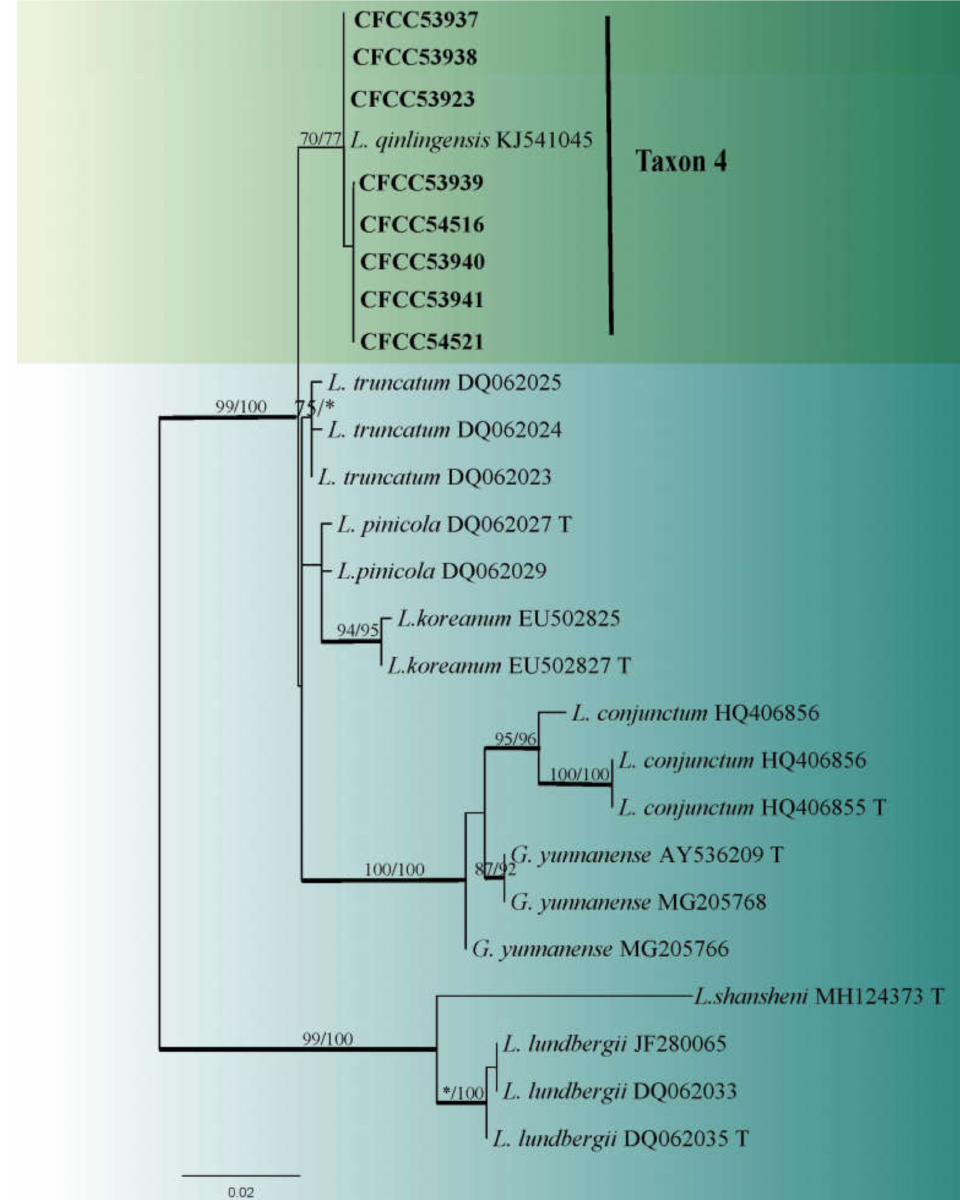
Figure 6. ML tree of L. lundbergii complex (Taxon 4) generated from the TEF1- α sequence data. Novel sequences obtained in this study are presented in bold typeface. Bold branches indicate posterior probability values ≥ 0.9. Bootstrap values ≥ 70% for ML and MP are indicated above branches. Bootstrap values < 70% are indicated by *. Strains representing ex-type sequences are marked with